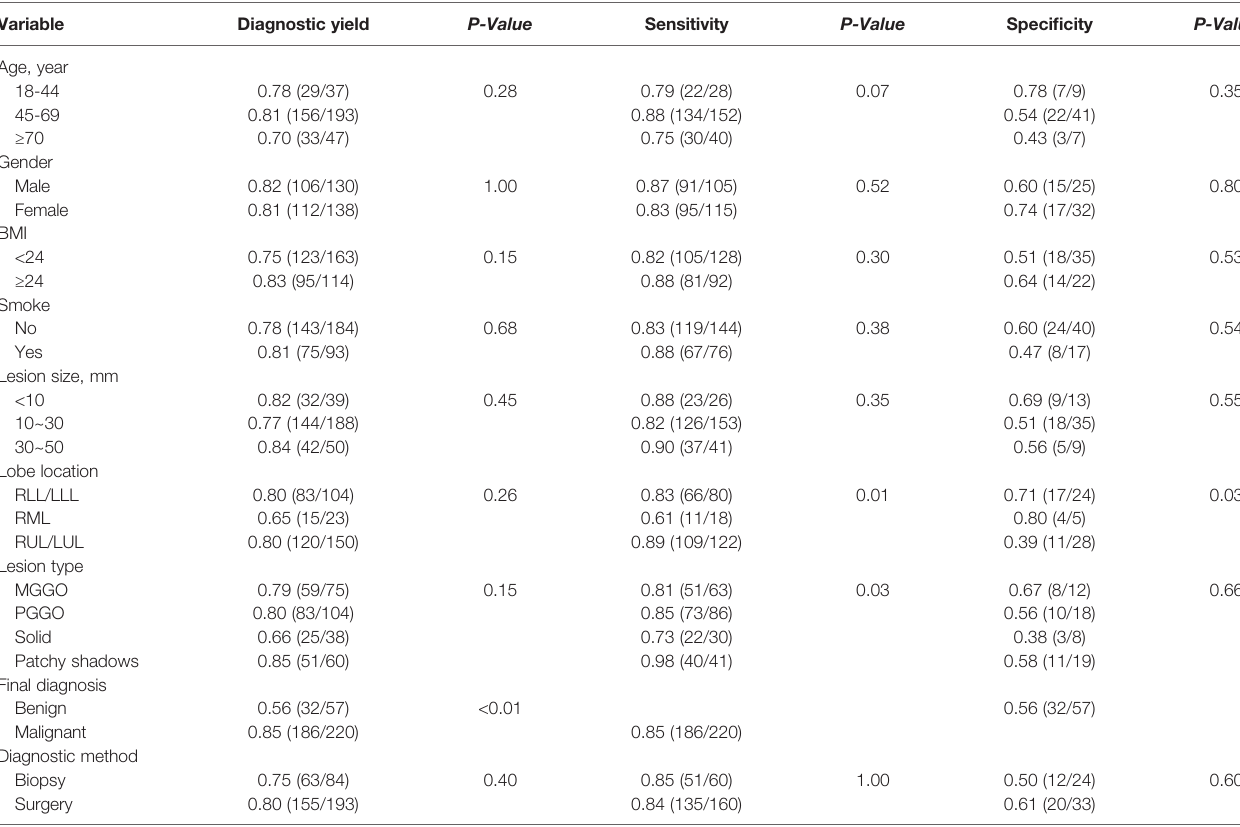
TABLE 4 | Diagnostic yield in the clinical validation dataset by different variables. Variable